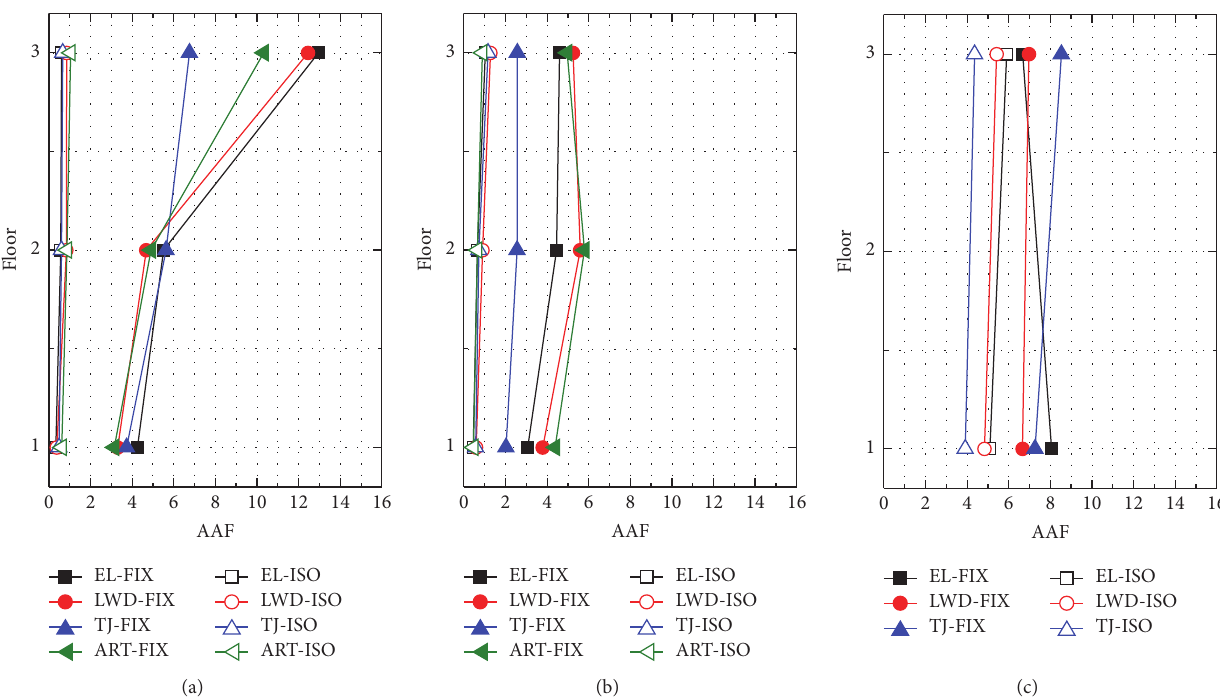
Figure 19: Comparisons on profiles of “Treasures fill the house” AAFs for the isolated and fixed structure under moderate earthquake: (a) direction x ; (b) direction y ; and (c) direction z